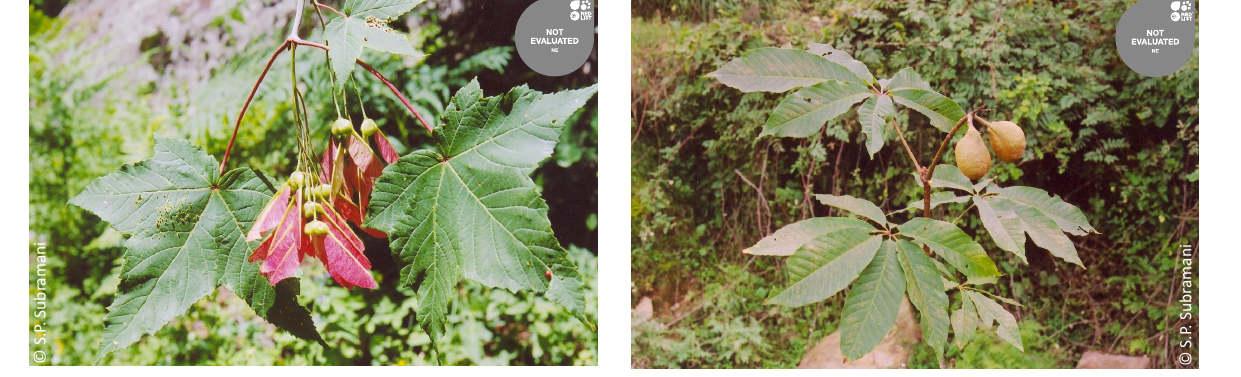
Image 34. Aesculus indica (Wall. ex Cambess.) Hook